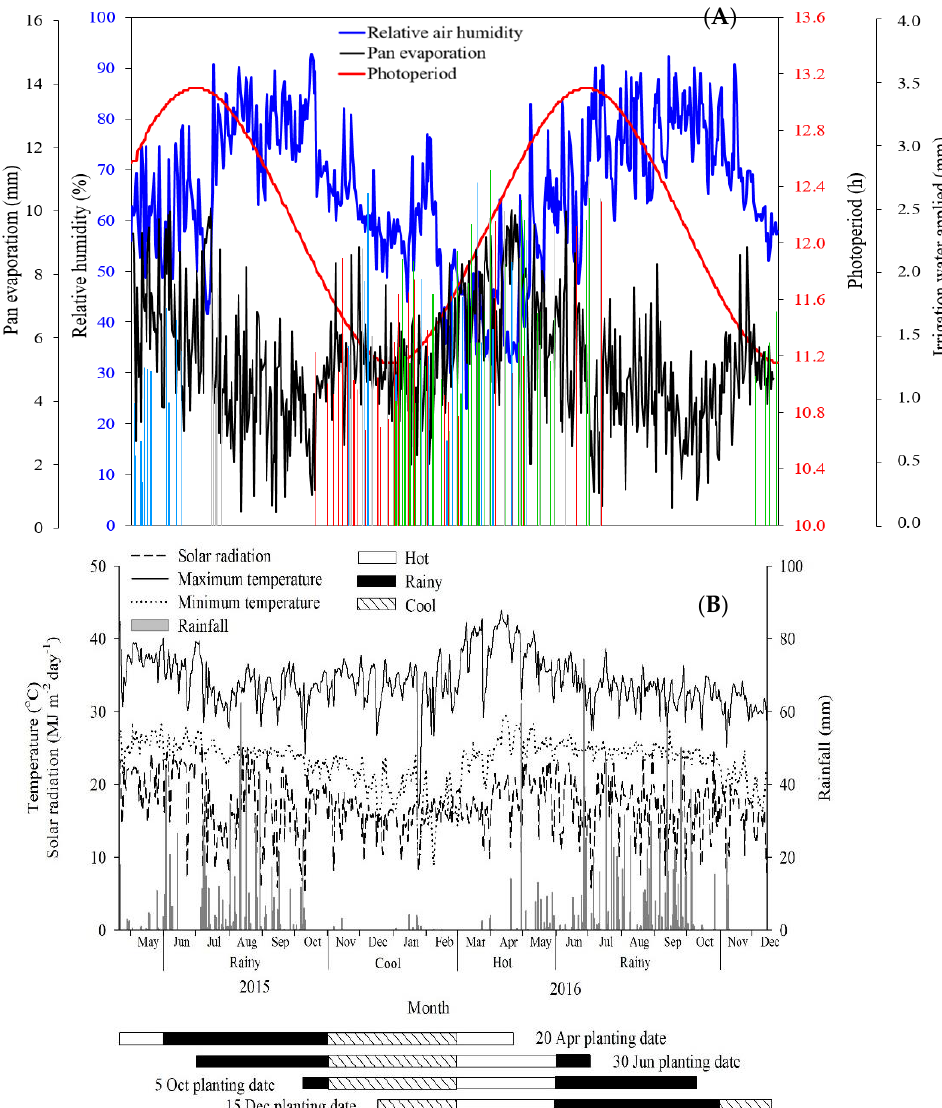
Figure 1. Pan evaporation (mm); relative air humidity (%); photoperiod (h); irrigation events (mm) ( A ); maximum and minimum air temperatures (°C); solar radiation (MJ m −2 day −1 ) and rainfall (mm) ( B ) during the crop growth period of cassava. The bar chart with different bar colors in Figure 1A represents the irrigation events during the crop growth period of cassava for different planting dates (blue, gray, red and green represent 20-Apr, 30-Jun, 5-Oct and 15-Dec, respectively). Table 2. The number of days the soil water potential fell below the critical level (−30 KPa) for cassava cv . Rayong 9 under irrigated and rainfed conditions using four planting dates .